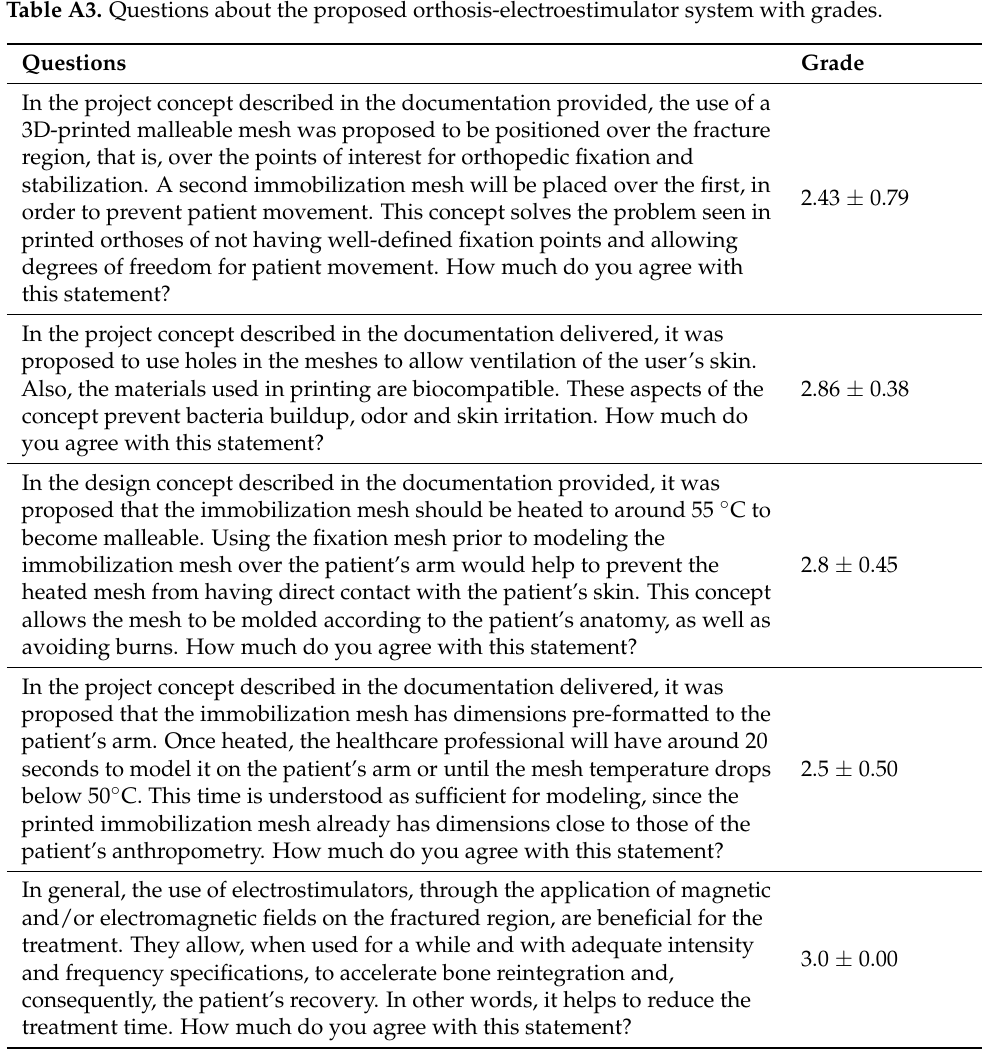
Table A3. Questions about the proposed orthosis-electroestimulator system with